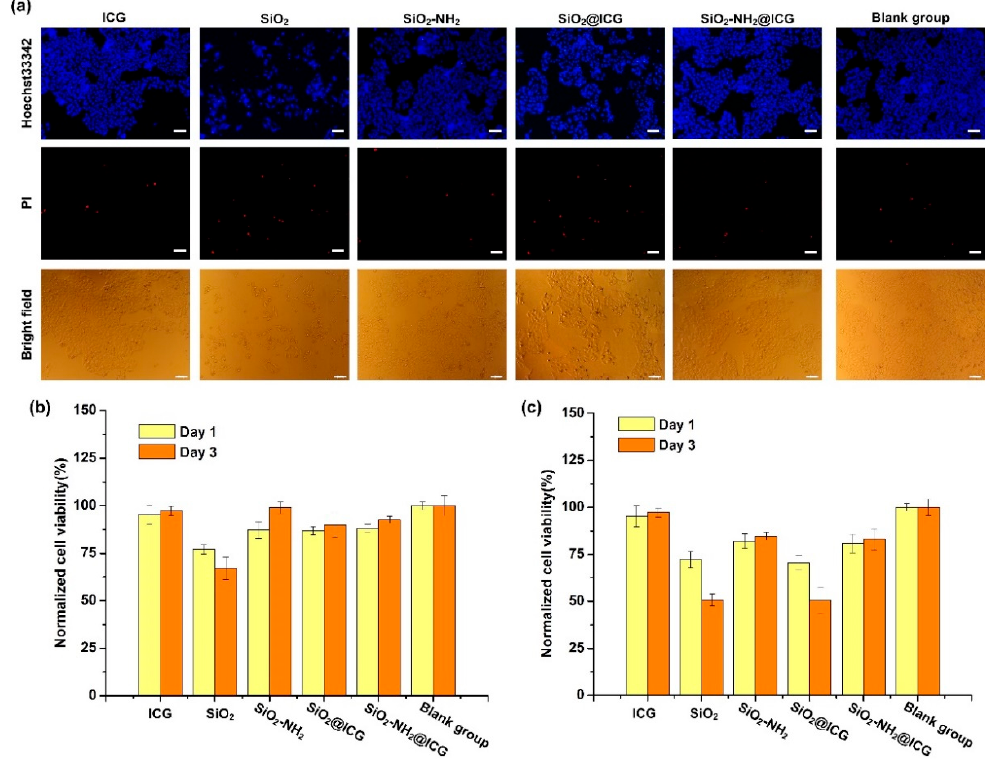
Figure 6. ( a ) The HepG2 cells treated with free ICG or different samples media after the 3-day culture were stained with Hoechst 33342 (blue) and PI (red) fluorescent dye (ICG concentration was fixed at 8 μ g/mL), scale bars, 100 μ m. ( b ) Viability of HepG2 cells on the first and third days after incubation with ICG (4 μ g/mL) or different samples media (50 μ g/mL) but without laser irradiation. ( c ) Viability of HepG2 cells on the first and third days after incubation with ICG (8 μ g/mL) or different samples media (100 μ g/mL) but without laser irradiation.